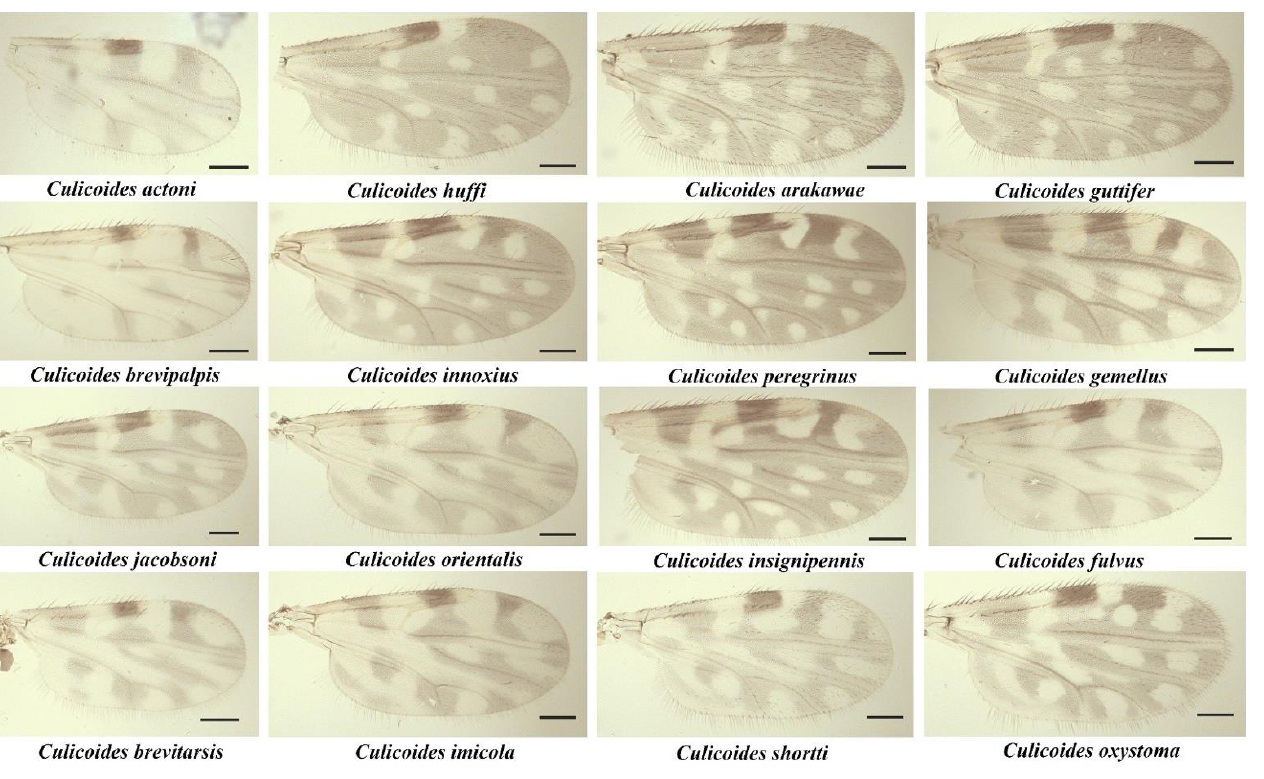
Figure 3. Photographs of wing patterns of 16 representatives Culicoides species collected from this study, scale bar: 100 µm.